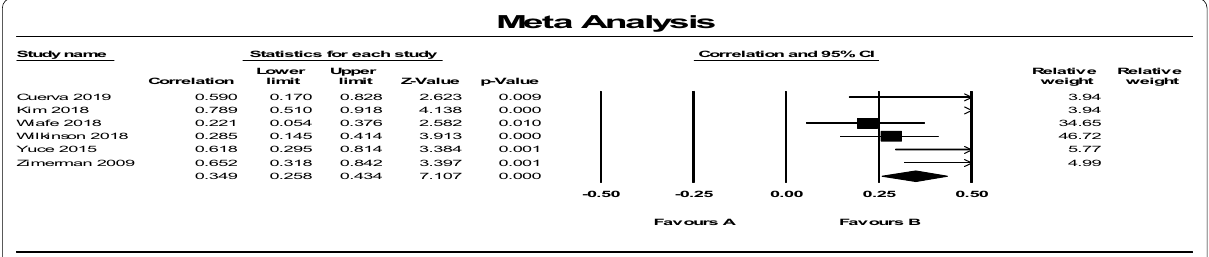
Fig. 4 Average intra-tester and inter-session reliability of ICC between ultrasound measurements and digital examinations of cervical dilatation in nulliparous